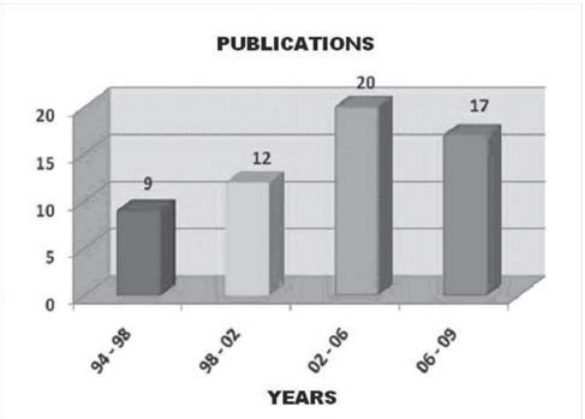
Fig. 3 - Quadrienal distribution of